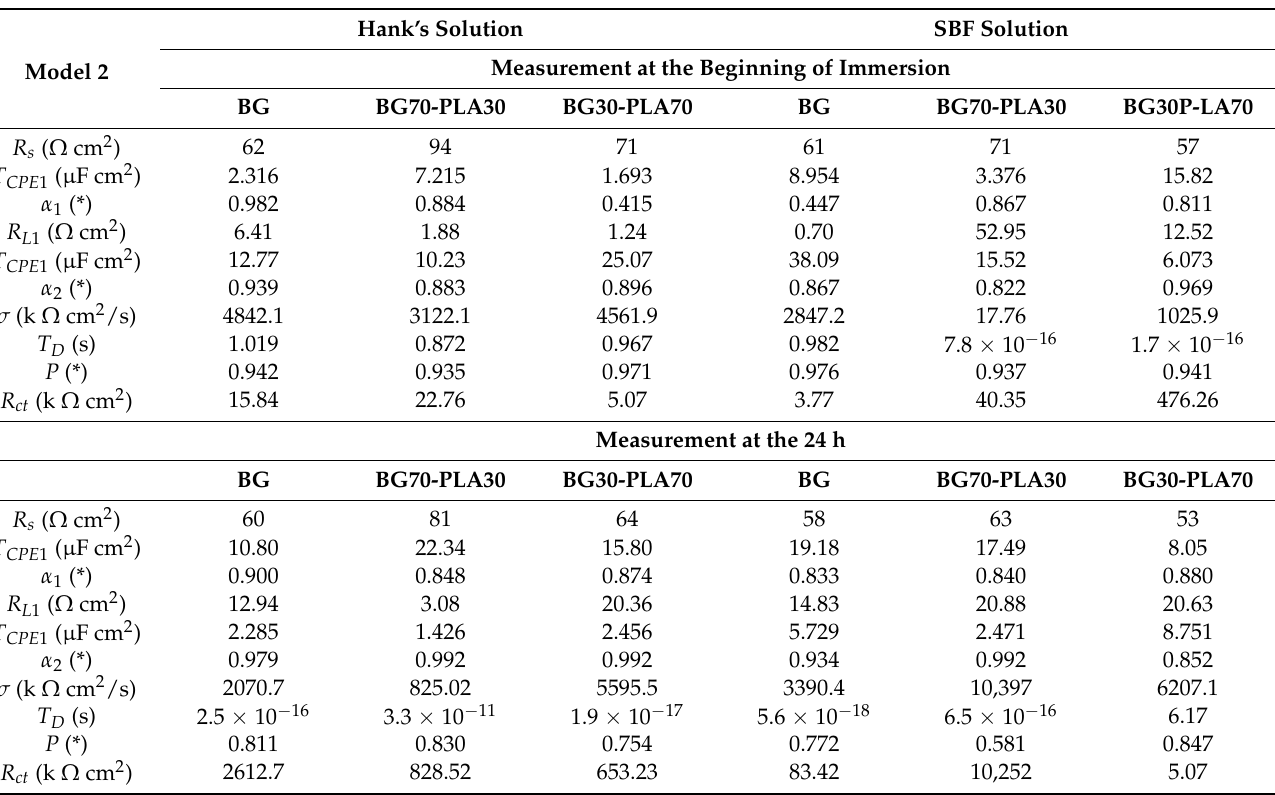
Table 9. EIS Parameters obtained by fitting the experimental data for the BG-PLA coatings using Model 2, Figure